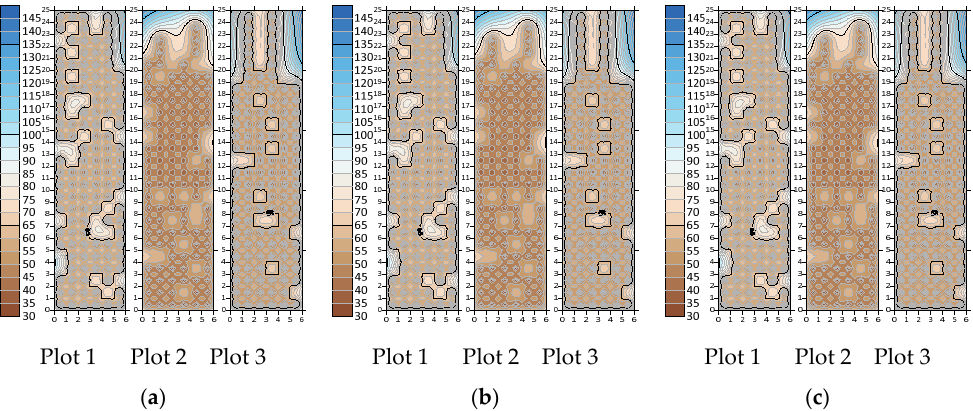
Figure 3. Kriging standard deviations derived from the implementation of spatial interpolation on the three crop parameters: ( a ) Fresh weight (FW); ( b ) Dried weight (DW); ( c ) Ear weight (EW) of all harvested individual plants. Areas with lower standard deviation (SD) values appear as “data holes” in the plots, and they correspond to the missing values. Areas with even lower data density (upper part of plots) have higher estimated standard deviation values concerning the implementation of